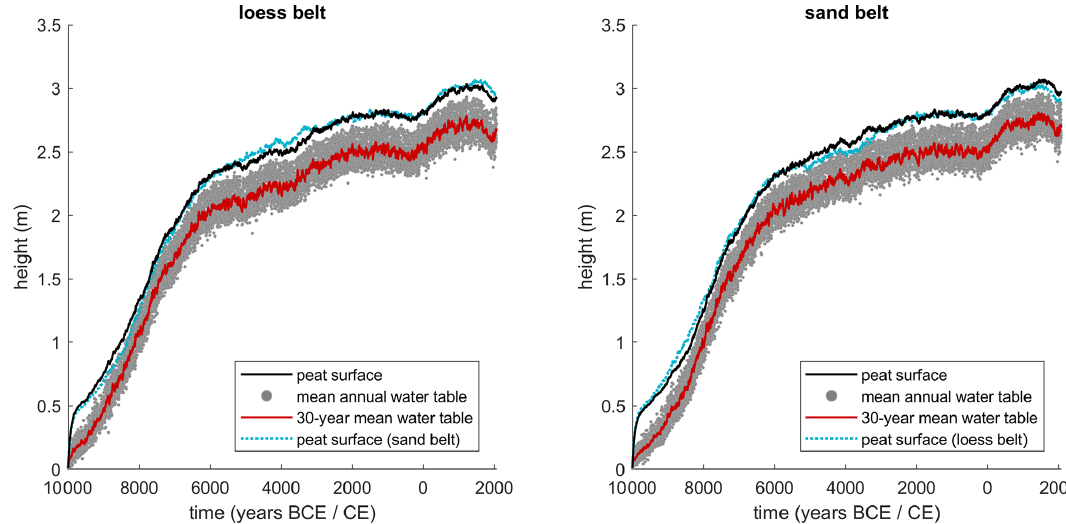
Figure 5. Simulated evolution of an alluvial peatland for both the loess and sand belts since